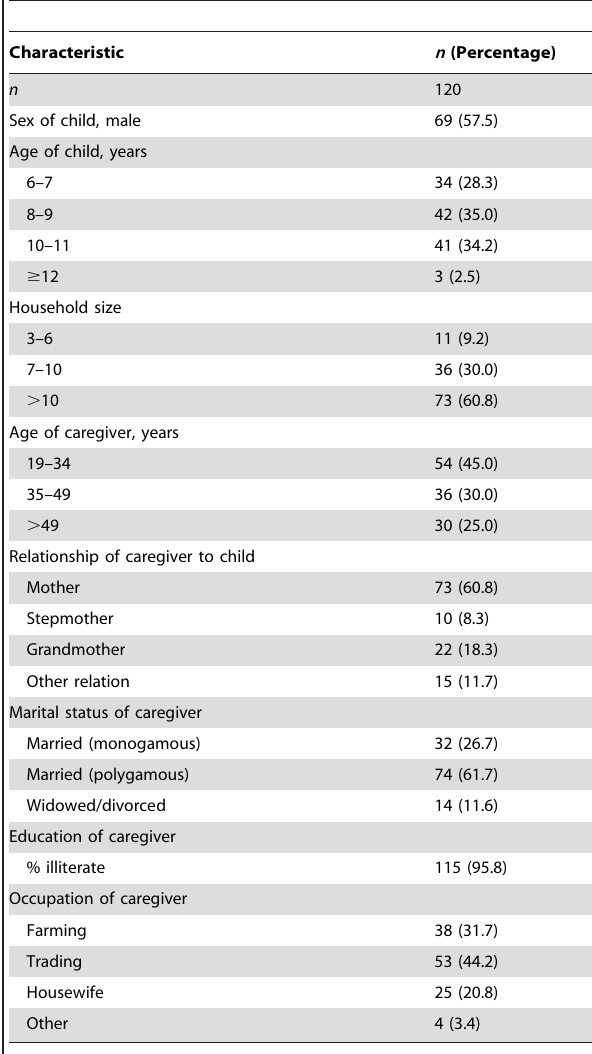
Table 4. Background characteristics of schoolchildren and their caregivers in northern